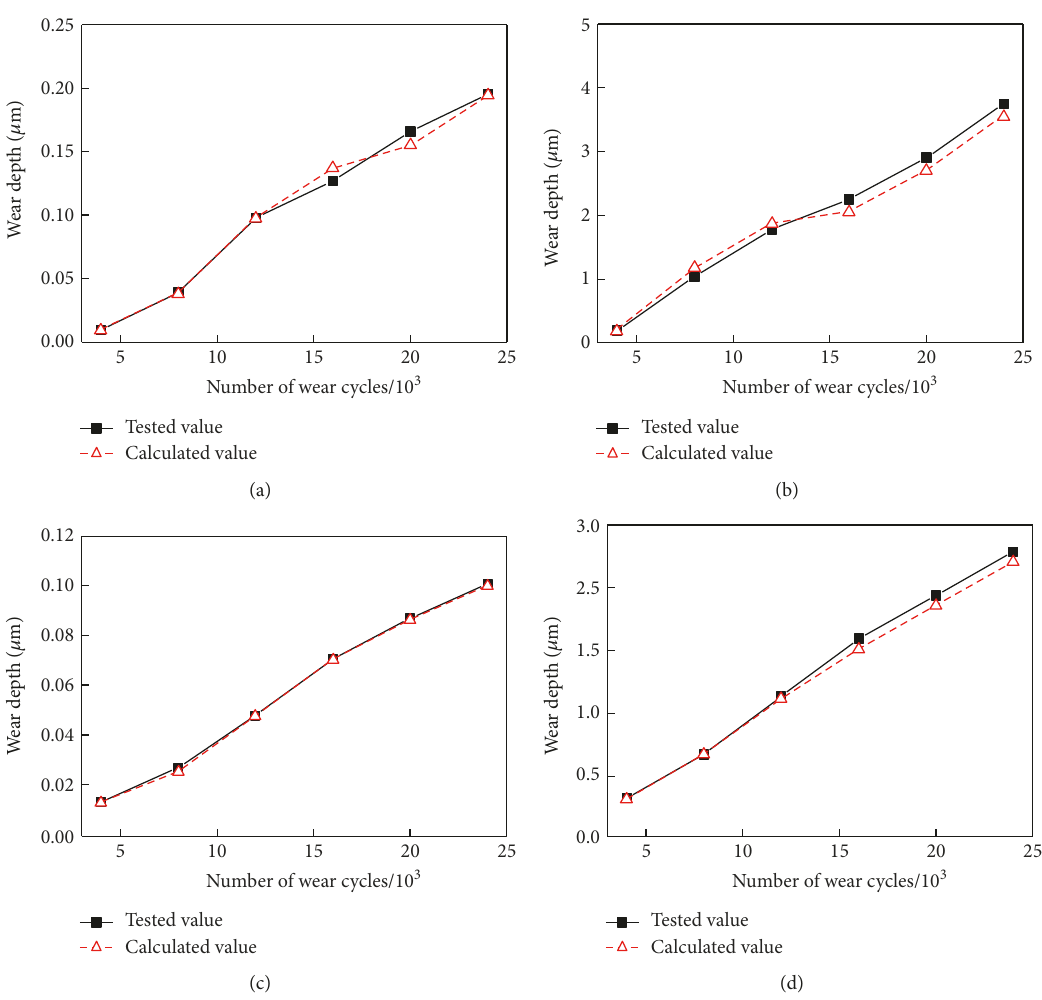
Figure 6: Wear depth of the friction couple number 1 (a), number 2 (b), number 5 (c), and number 7